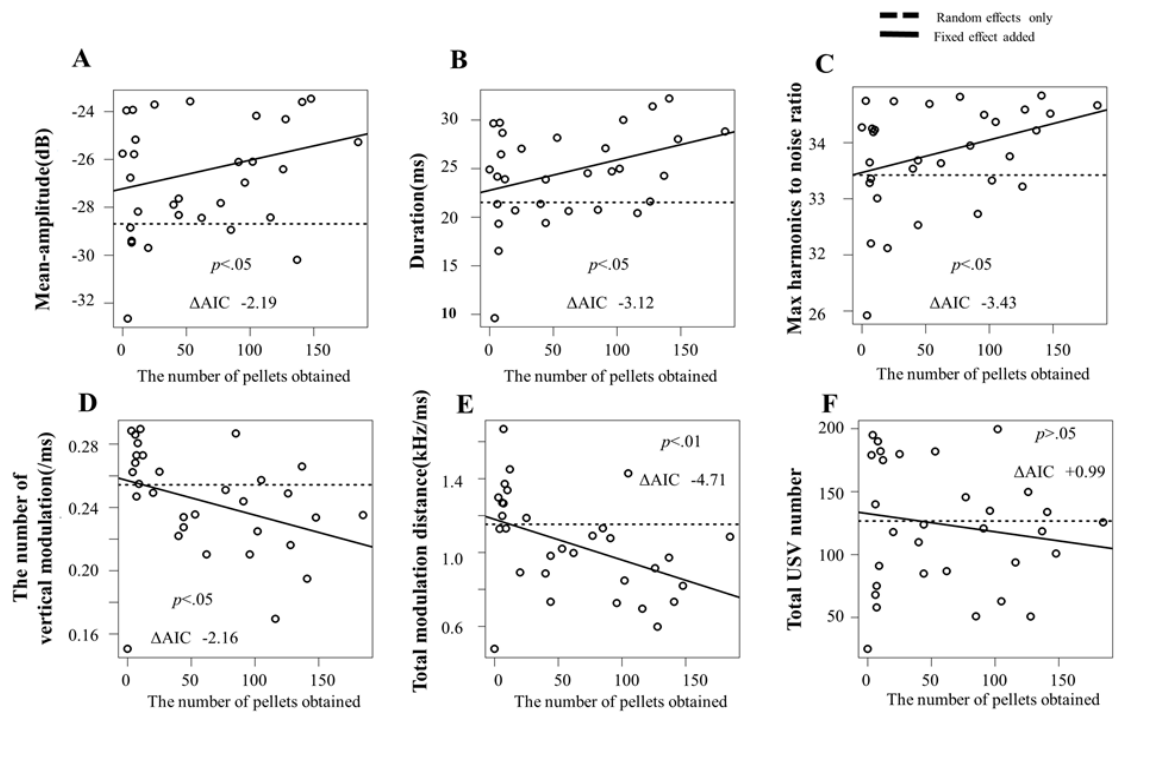
Figure 4 . Changes in the acoustic features with an increase in acquired reward. A) Mean-amplitude. B) Duration. C) Max harmonics to noise ratio. D) The number of vertical modulation. E) Total modulation distance. F) Total USVs number. Each open circle represents the averaged feature value for each day and each individual. Random effects were the length of the waiting phase and individual differences. The fixed effect was the number of pellets